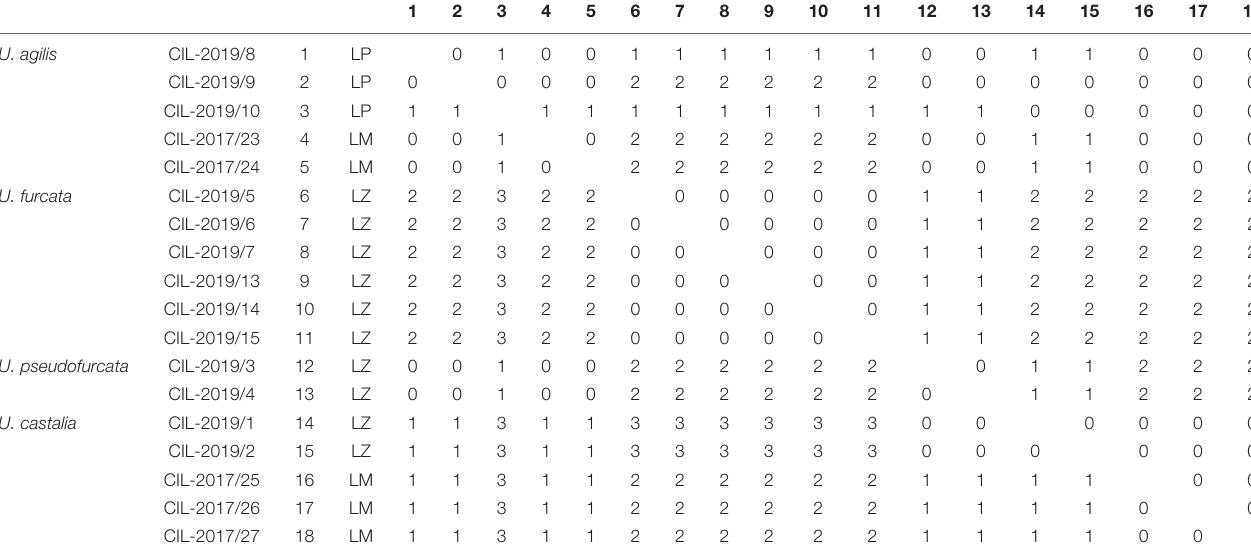
TABLE 3 | Compensatory base changes and hemi-compensatory base changes among the ITS-2 rDNA sequences of the investigated Urotricha strains.